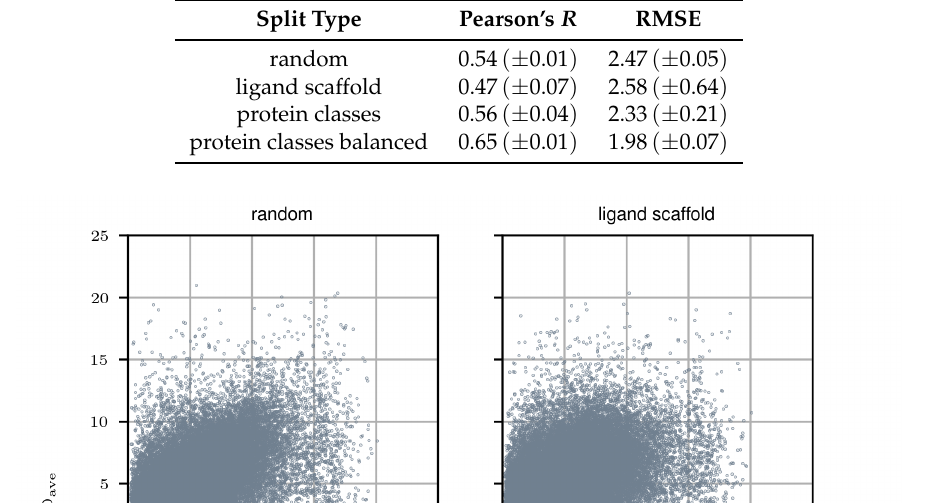
Table 2. Ligand-centric evaluation (RMSD ave , this study.